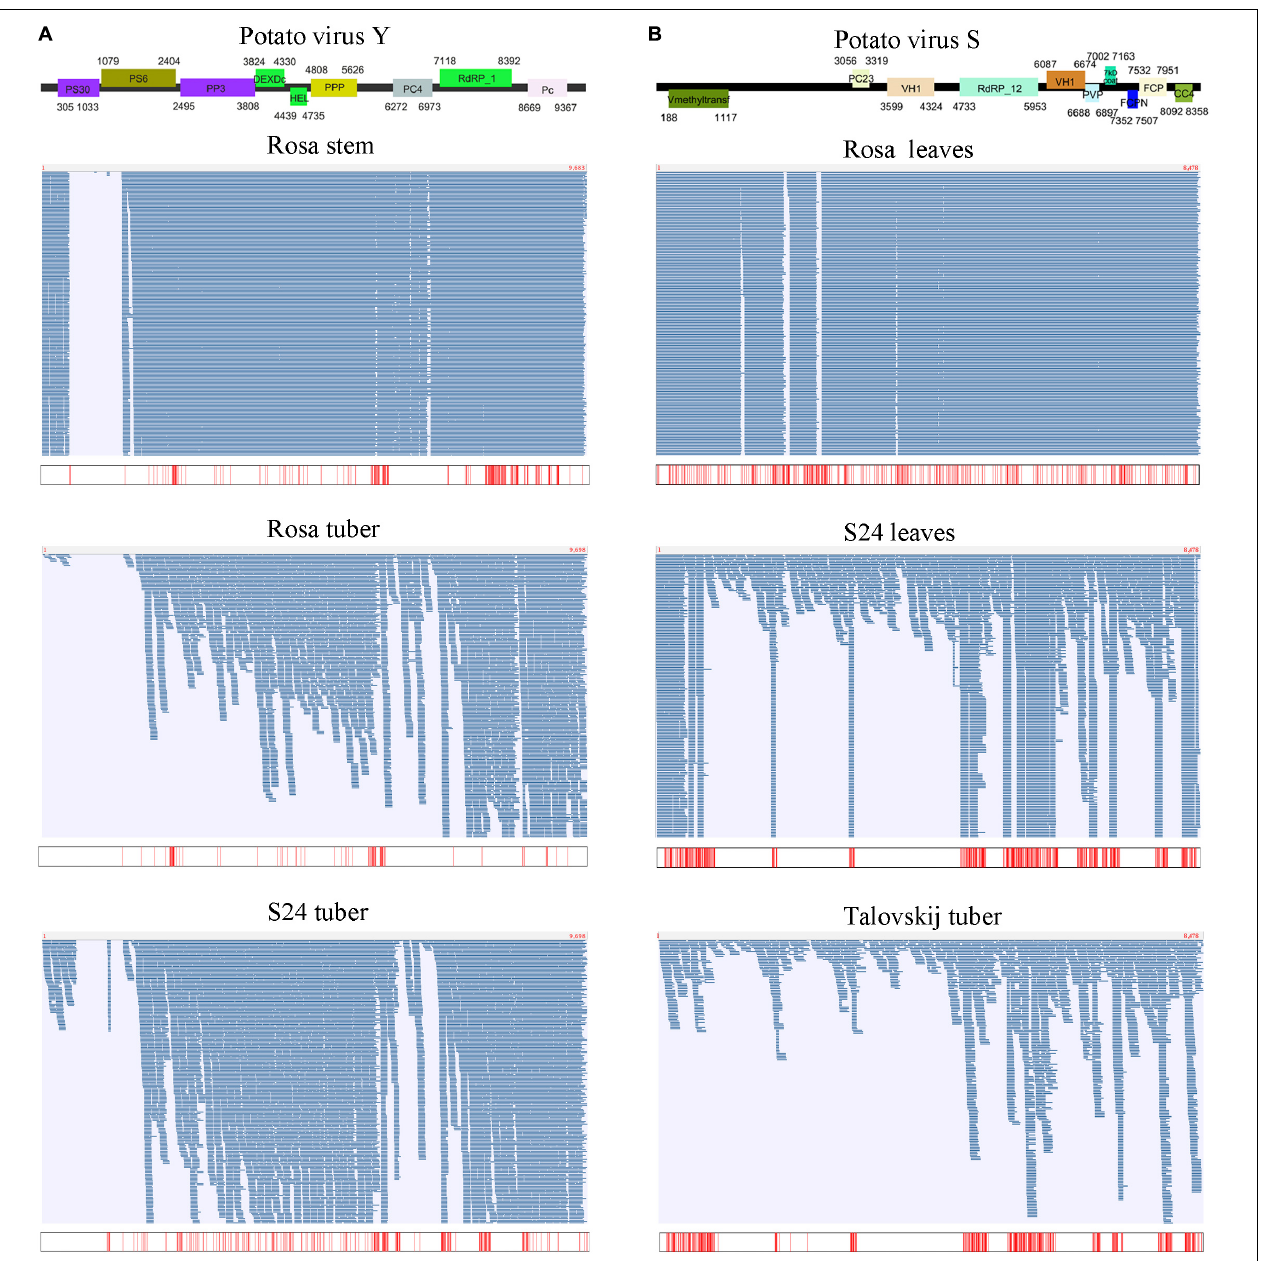
FIGURE 5 | Assembly of viral genomes and SNP analyses for PVY (A) and PVS (B) . The upper part shows the organization of the assembled viral genome. The lower part shows the mapping results of sequence reads on the assembled viral genome among different cultivars and tissues, and the positions of identified SNPs are shown